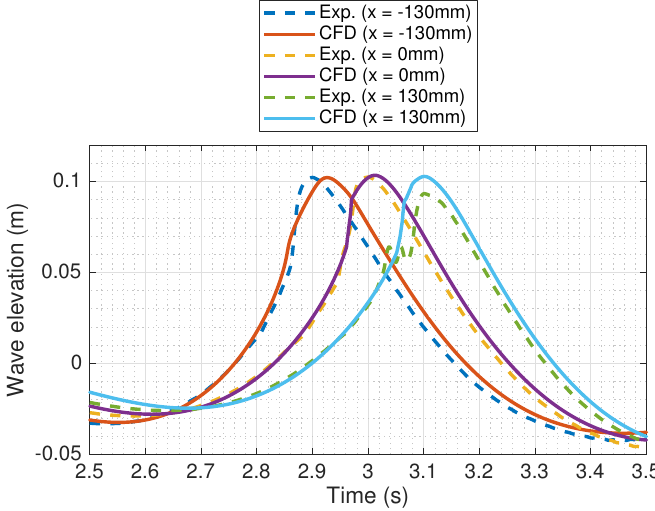
Figure 16. Wave elevation histories for the plunging breaker at three locations; the target location at x = 0 m and 130 mm before and after the target